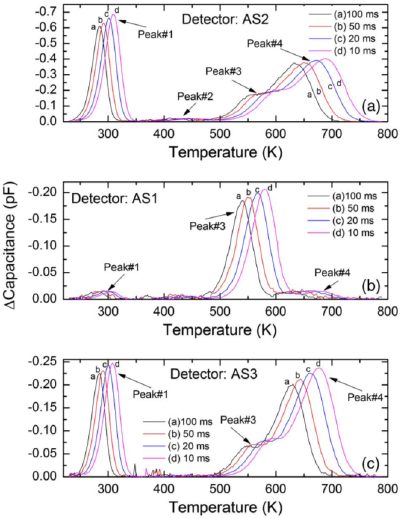
Figure 24. Capacitance - DLTS spectra obtained in the temperature range 250–750 K for ( a ) AS2, ( b ) AS1, and ( c ) AS3. The detectors were fabricated on n-S20 type epitaxial layers. Micromachines 2020 , 11 , 254